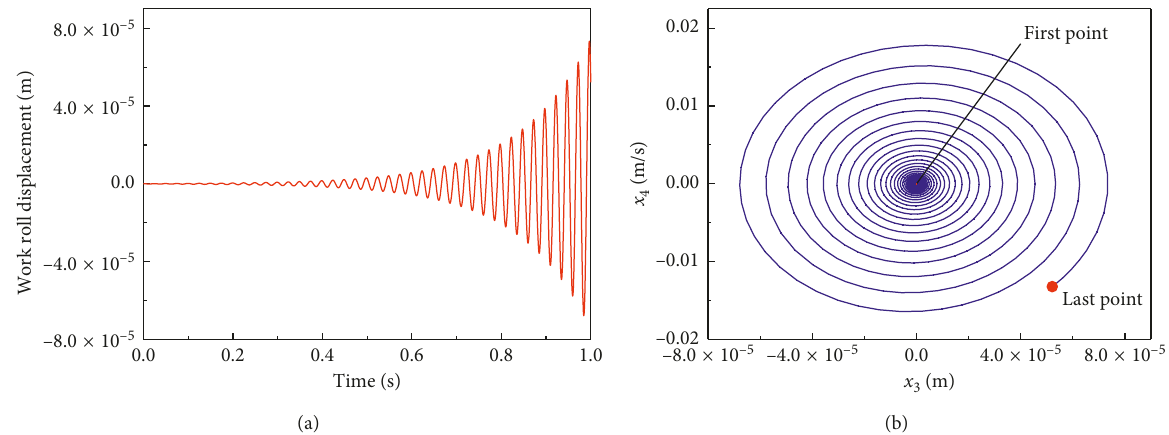
Figure 5: Dynamic response of the work roll displacement and the phase diagram under μ ∗ � 0 . 0040: (a) time history of work roll displacement; (b) phase diagram.